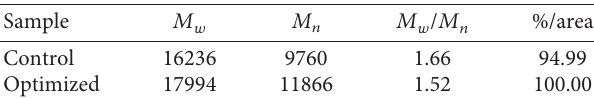
Figure 5: Isolation and purification of crude FTP. (a) The DEAE-Sepharose fast flow ion exchange chromatography elution curve for FTP in the control and optimized group. (b) The proportion of FTP-1, FTP-2, and FTP-3 in all purified components. Table 9: Molecular